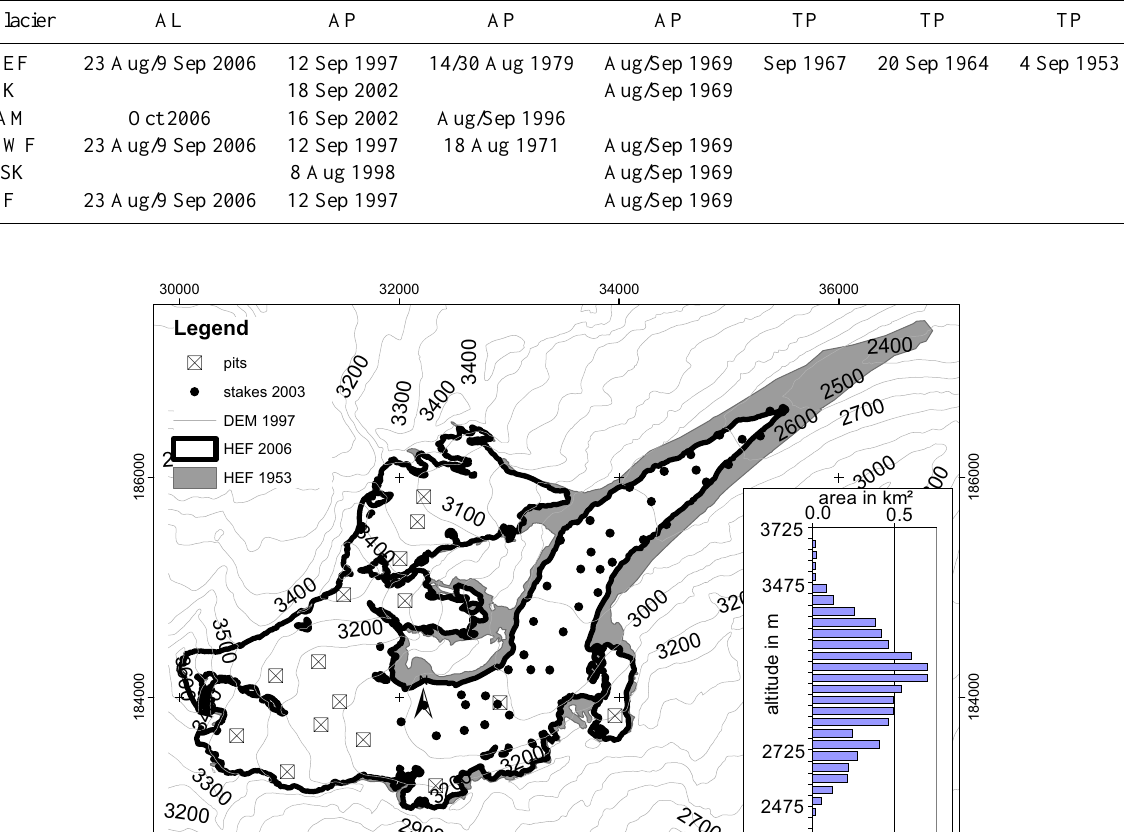
Table 2. Date and method of DEM acquisition at the test glaciers JAM, HEF, KWF, VF, SSK and HK. AL – airborne laser scanning, AP – airborne photogrammetry, TP – terrestrial photogrammetry. When months are given, the accurate date is not known, when two dates are given, the data is combined from two flights.